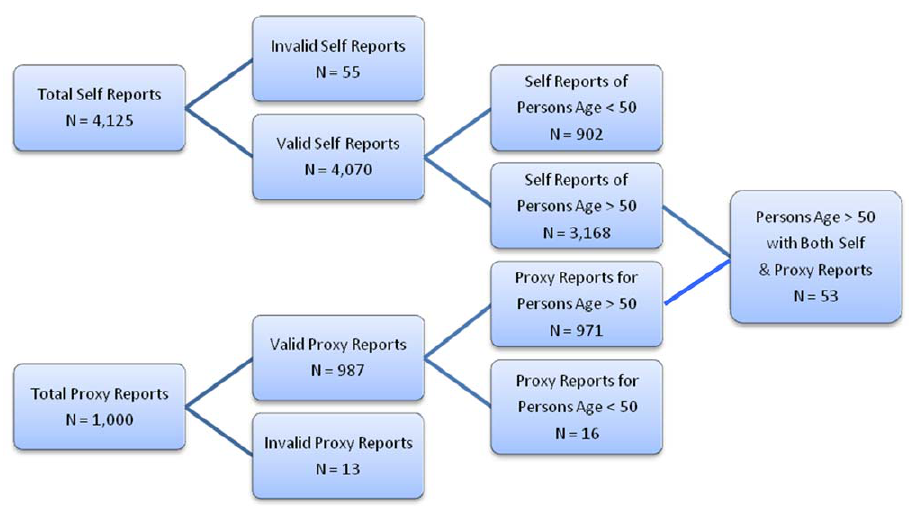
Figure 1. Anonymous Internet Sample.